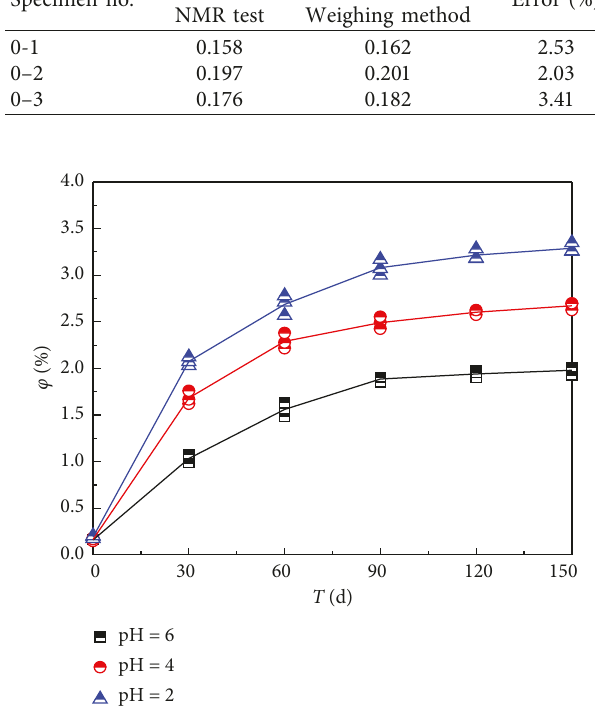
Figure 4: Variation in porosity versus corrosion time.